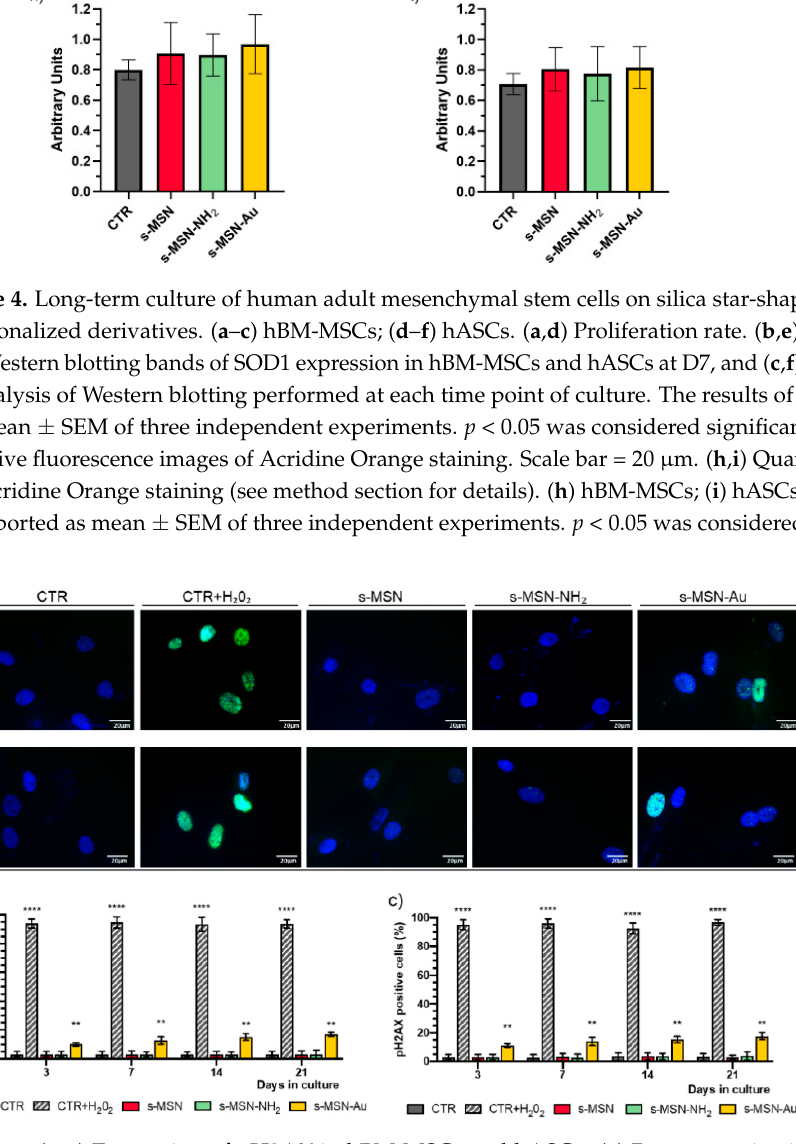
Figure 5. ( a – c ) Expression of pH2AX in hBM-MSCs and hASCs. ( a ) Representative immunofluo- rescence images with anti-pH2AX antibody (Green) and Nuclei (DAPI, blue). Scale bar = 20 µm. ( b , c ) Quantification of pH2AX expression in hBM-MSC S ( b ) and hASCs ( c ) performed at each time point of culture. Data are expressed as mean ± SEM, ** p < 0.01 **** p < 0.0001.